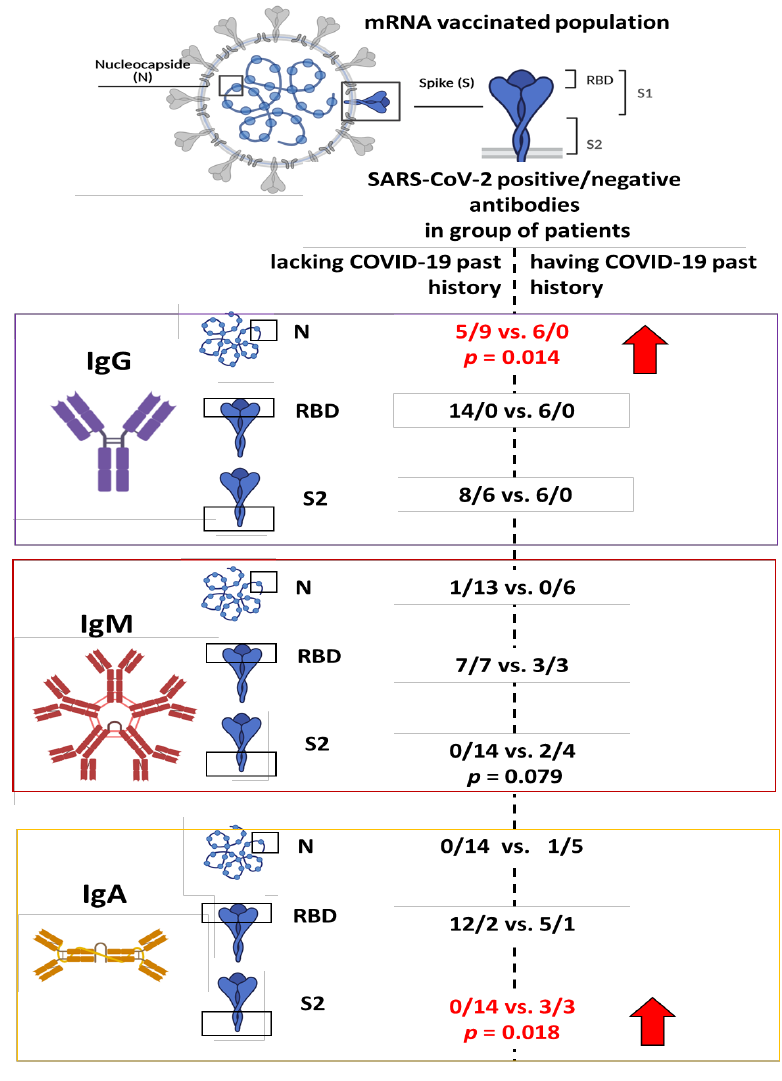
Figure 2. SARS-COV-2 antibodies in the individuals lacking or having COVID-19 prior to vaccination after completion of the immunization. Note that positive history of COVID-19 was associated with the presence of N and S2